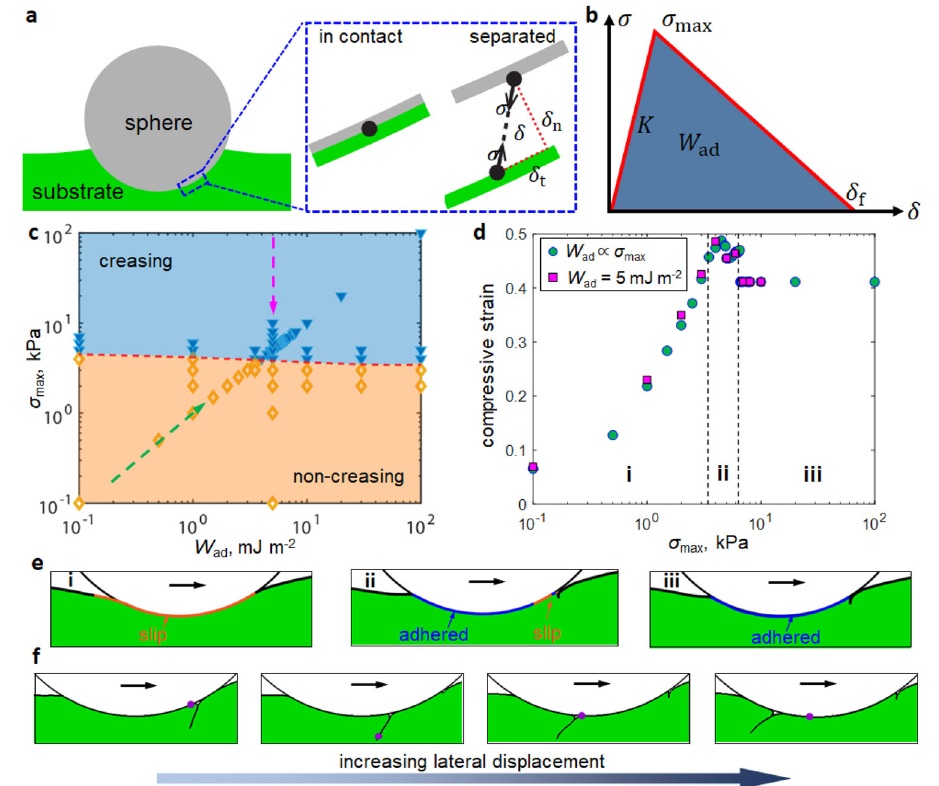
Fig. 4 | FEA simulations of crease nucleation and progression. a Schematic illustration of the contact between the rigid microsphere and the substrate (left). The inset on the right shows a zoomed-in view of the interface in its initial state whencontactisjustestablished,andtheseparatedstatewherethetwosurfacesare relatively displaced and thus a traction σ and separation δ are used to de fi ne the interfacial adhesion. δ n and δ t are the normal and tangential separations, respec- tively. b A cohesive zone model with bilinear traction-separation law is used to de fi ne the adhesion energy W ad on the interface. c Phase diagram for creasing in